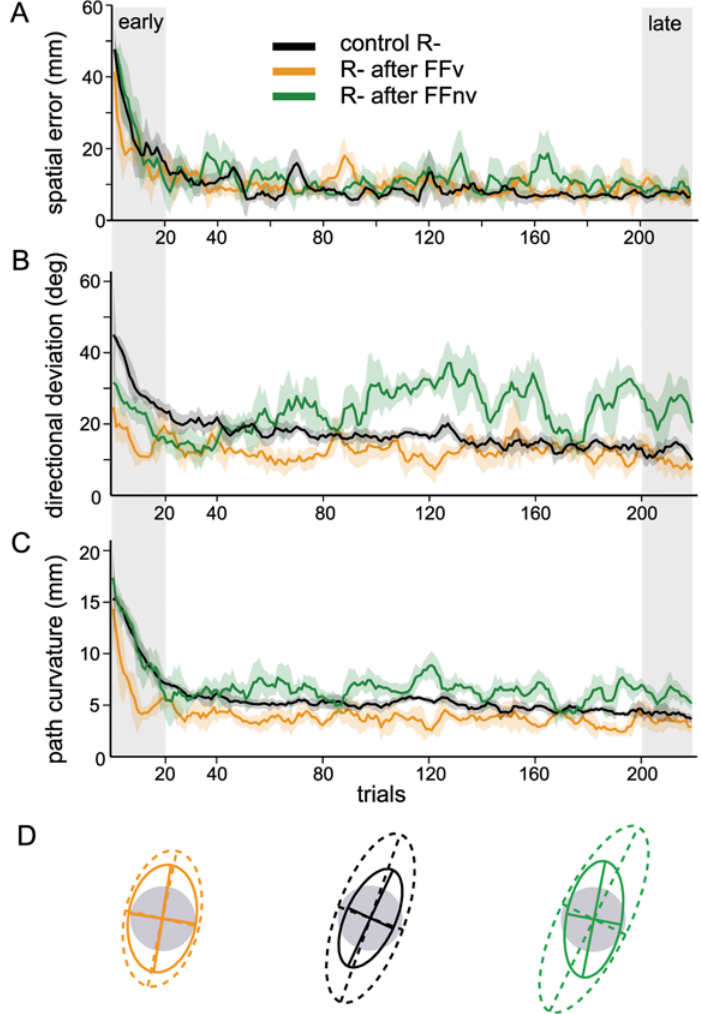
Figure 6. Effects of prior force field adaptations on matched visuomotor rotations. Group data. A–C, Time courses for the different movement parameters during adaptations to single rotation only (control R 2 ) and to rotations after learning force field with visual feedback (R 2 after FFv) and without (R 2 after FFnv). D, Endpoint variability ellipses of the first 40 (dotted lines) and last 40 (solid lines) rotation trials for all subjects in each